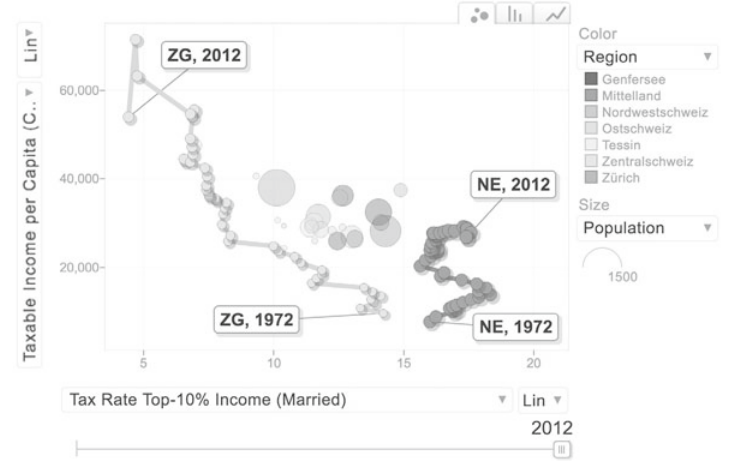
Figure 11: Taxable income per inhabitant (vertical axis) and Consolidated cantonal (cid:2) municipal effective average tax rate for a married couple without children and top-10% income (horizontal axis) across Swiss cantons 2012 with evolution since 1972 for the cantons of Zug (ZG) and Neuchâtel (NE). Average across municipalities weighted by the number of